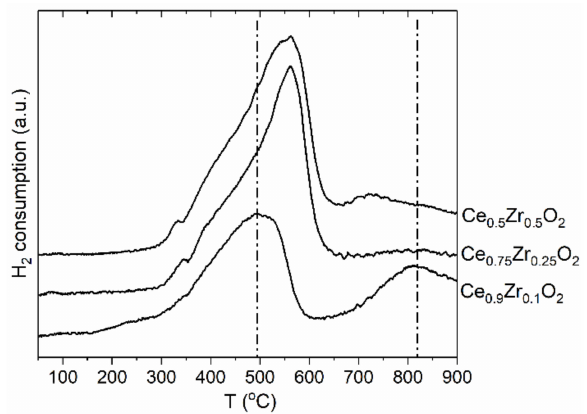
Figure 3. The H 2 -TPR profiles of the Ce 1 − x Zr x O 2